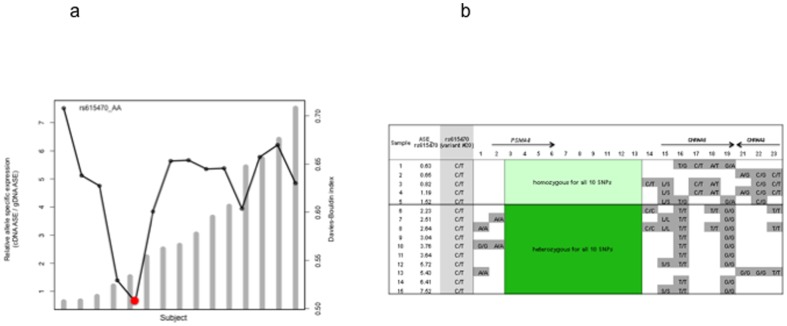
Allele specific expression (ASE) analysis with rs615470 in 15 frontal cortices of African ancestry.4a. Davies-Bouldin (DB) validity index analysis. Columns represent the ASE. Dotted line represents the DB validity index. The red dot indicates the optimal d cutoff predicted by the DB index that coincides with ASE. 4b. Concordance of allelic expression variation with heterozygosity. Samples #1 to #5 which show relative allelic expression balance (*ASE<2) are homozygous for all 10 SNPs highlighted. Samples #6 to #15 which show relative allelic expression imbalance are heterozygous for all 10 SNPs. *See material and method for details; ASE: relative allele specific expression.